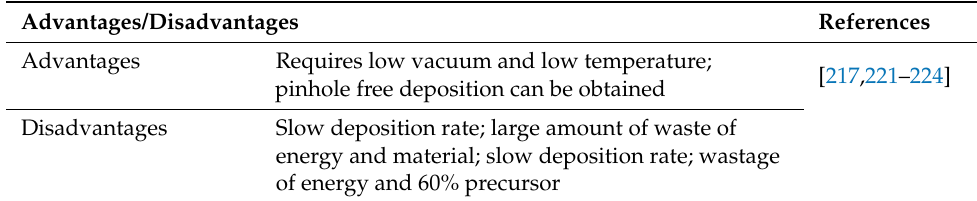
Table 16. Some of the significant advantages and disadvantages of atomic layer deposition are mentioned in this